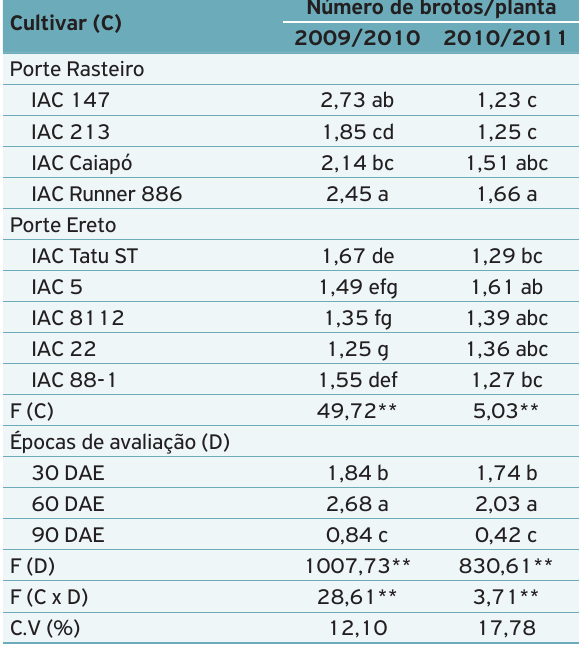
Tabela 3. Número médio de brotos por planta em